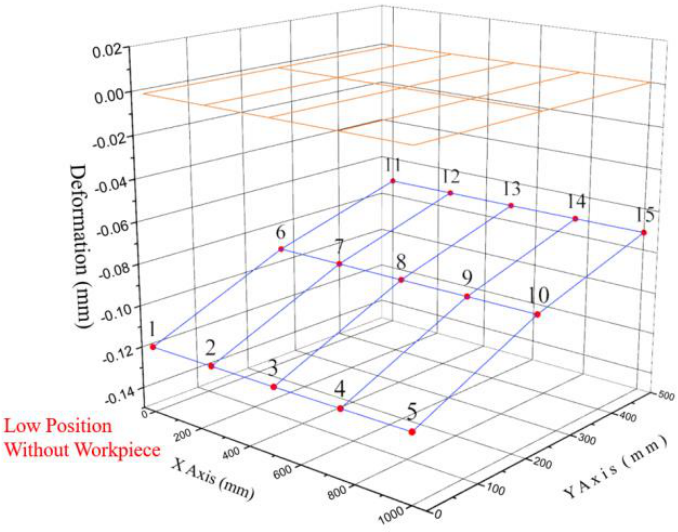
Figure 9. Schematic diagram of the low point of the spindle with load.